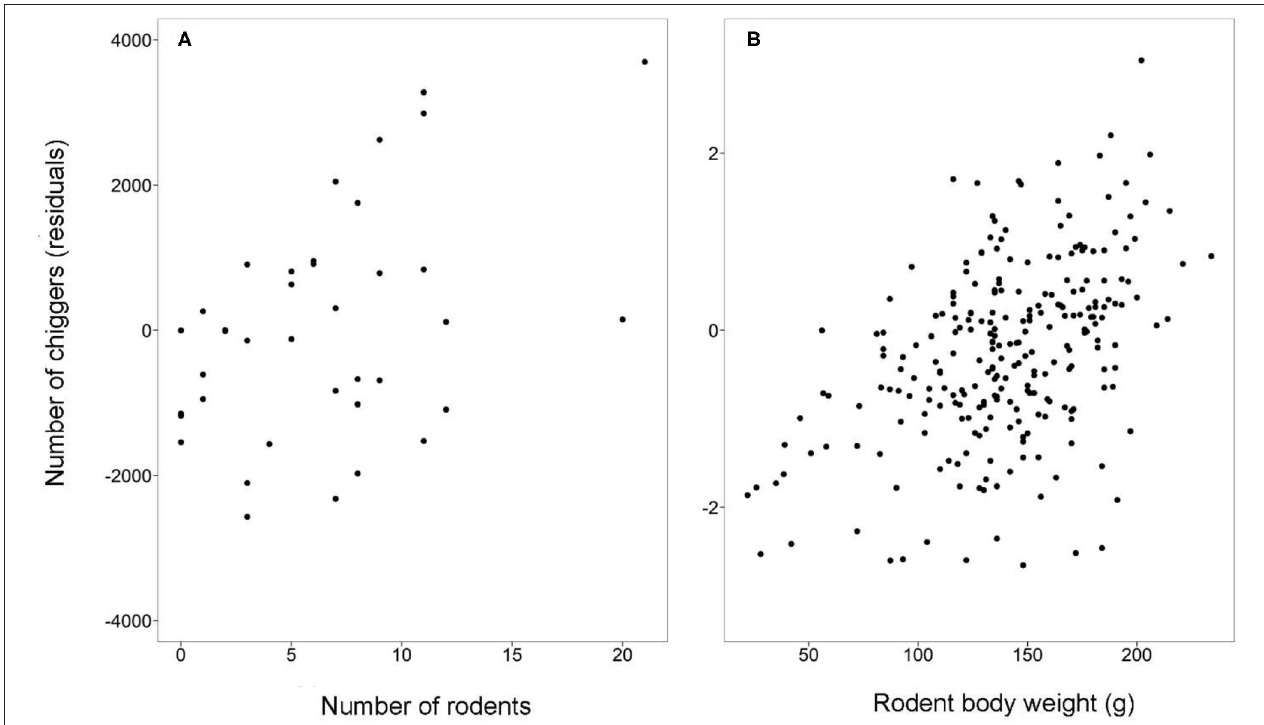
FIGURE 4 | Scatterplots of the number of chiggers (residuals, controlled for effect of habitat, month, and their interactions) against (A) the number of rodents per study site and (B) rodent body weight. Both scatterplots show significantly positive associations (see the Results).